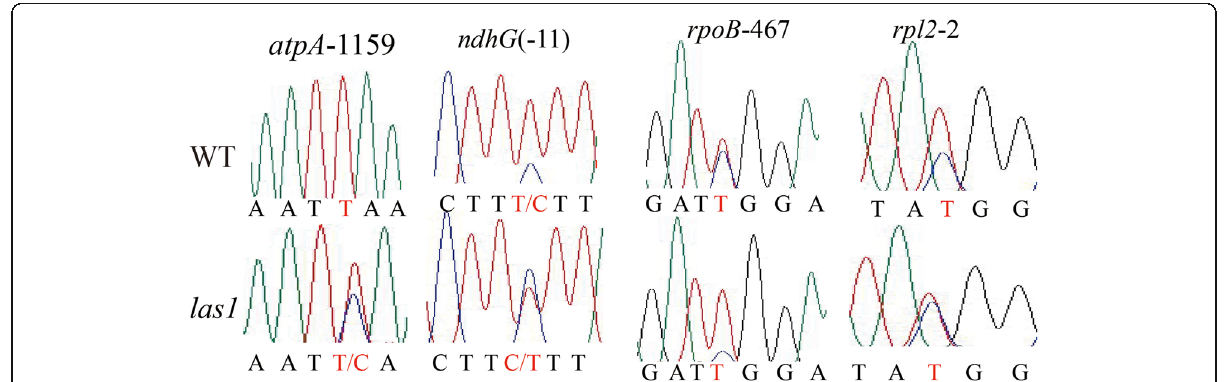
Fig. 7 The OsHMBPP protein is required for RNA editing at multiple